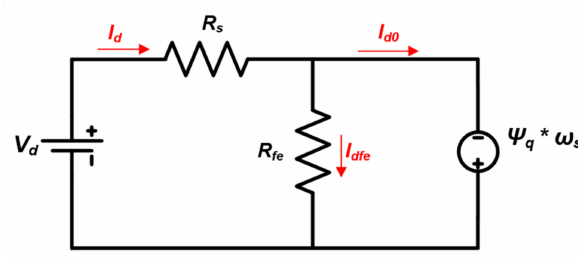
Figure 2. d–axis equivalent circuit.